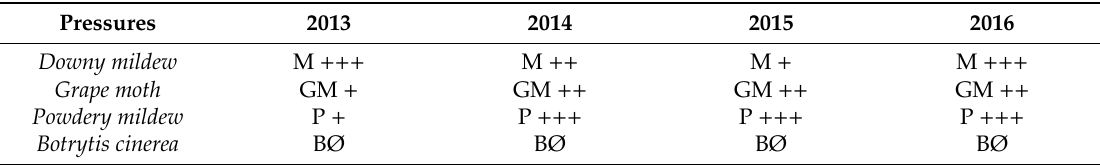
Table 2. Pest and disease conditions for each year of the study. Scale adapted from [15]: Ø no pressure, + average pressure, ++ high pressure, +++ very high pressure; M: Downy mildew, B: Botrytis cinerea ; P: Powdery mildew; and GM: Grape